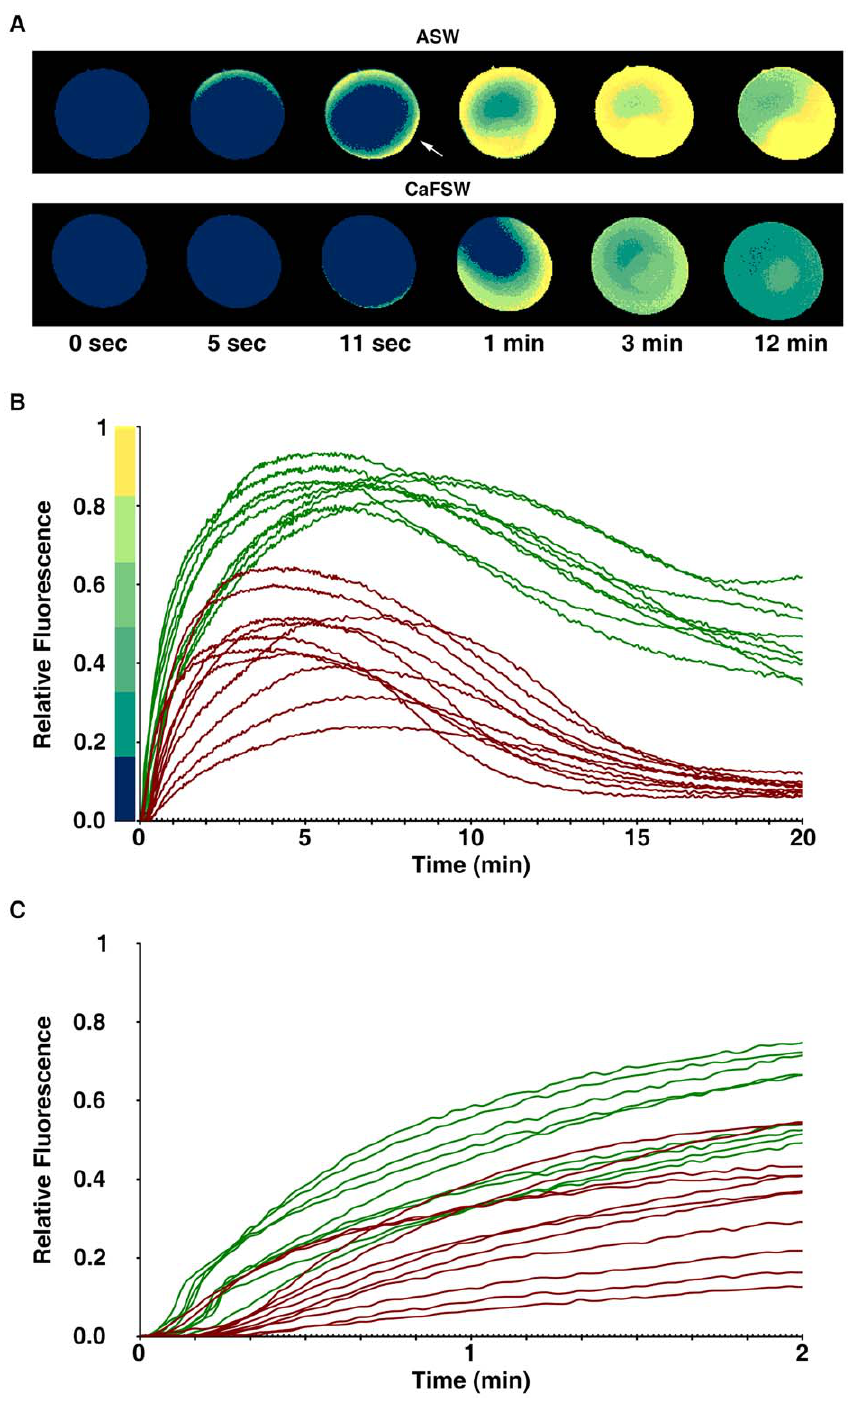
Figure 1. Changes of intracellular Ca 2 + levels in the starfish oocytes exposed to ionomycin. A. aranciacus oocytes at the GV stage were microinjected with Calcium Green/Rhodamine Red and subsequently exposed to 5 m M ionomycin in artificial seawater in the presence (ASW) or absence (CaFSW) of 10 mM Ca 2 + . Ca 2 + images were then captured with epifluorescence microscopy as described in Materials and Methods. ( A ) The pseudocolored images of Ca 2 + changes within the representative oocytes at several key time points. Indicated by an arrow is the cortical flash. ( B ) The trajectories of the Ca 2 + responses quantified at the entire cytoplasmic field. The Ca 2 + responses in ASW and CaFSW are represented in green and brown curves, respectively. To compare the kinetics of the Ca 2 + rises in ASW and CaFSW, the moment of the first detectable Ca 2 + signal was set to t=0 in panels A and B. ( C ) The initial response of the oocytes to ionomycin in ASW (green curves) and CaFSW (brown curves). To better illustrate the difference in the time lag before the first detectable Ca 2 + rise, the moment of the ionomycin addition was set to t=0 in this panel.